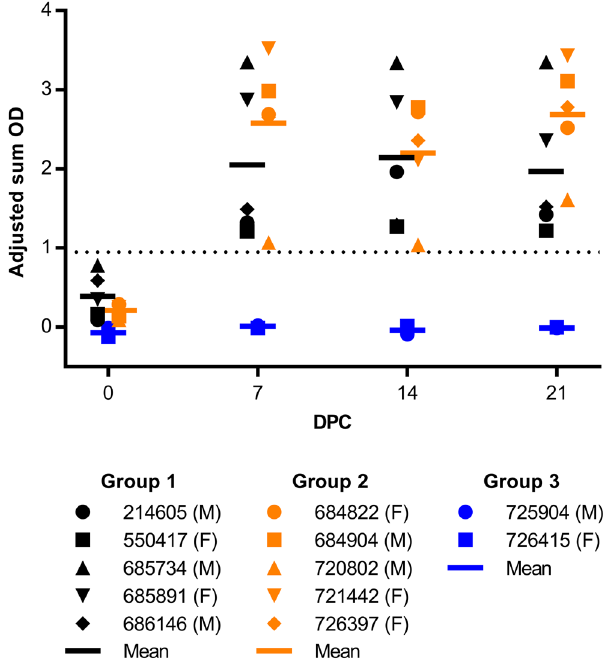
Figure 1. MARV IgG antibody responses of bats according to group. IgG antibodies were detected by ELISA with purified recombinant nucleoprotein of the Angola strain of MARV expressed in Escherichia coli from blood taken at 0, 7, 14 and 21 DPC. IgG antibody levels are expressed as adjusted sum OD values. The dotted line represents the threshold of the assay (MARV seropositive ≥